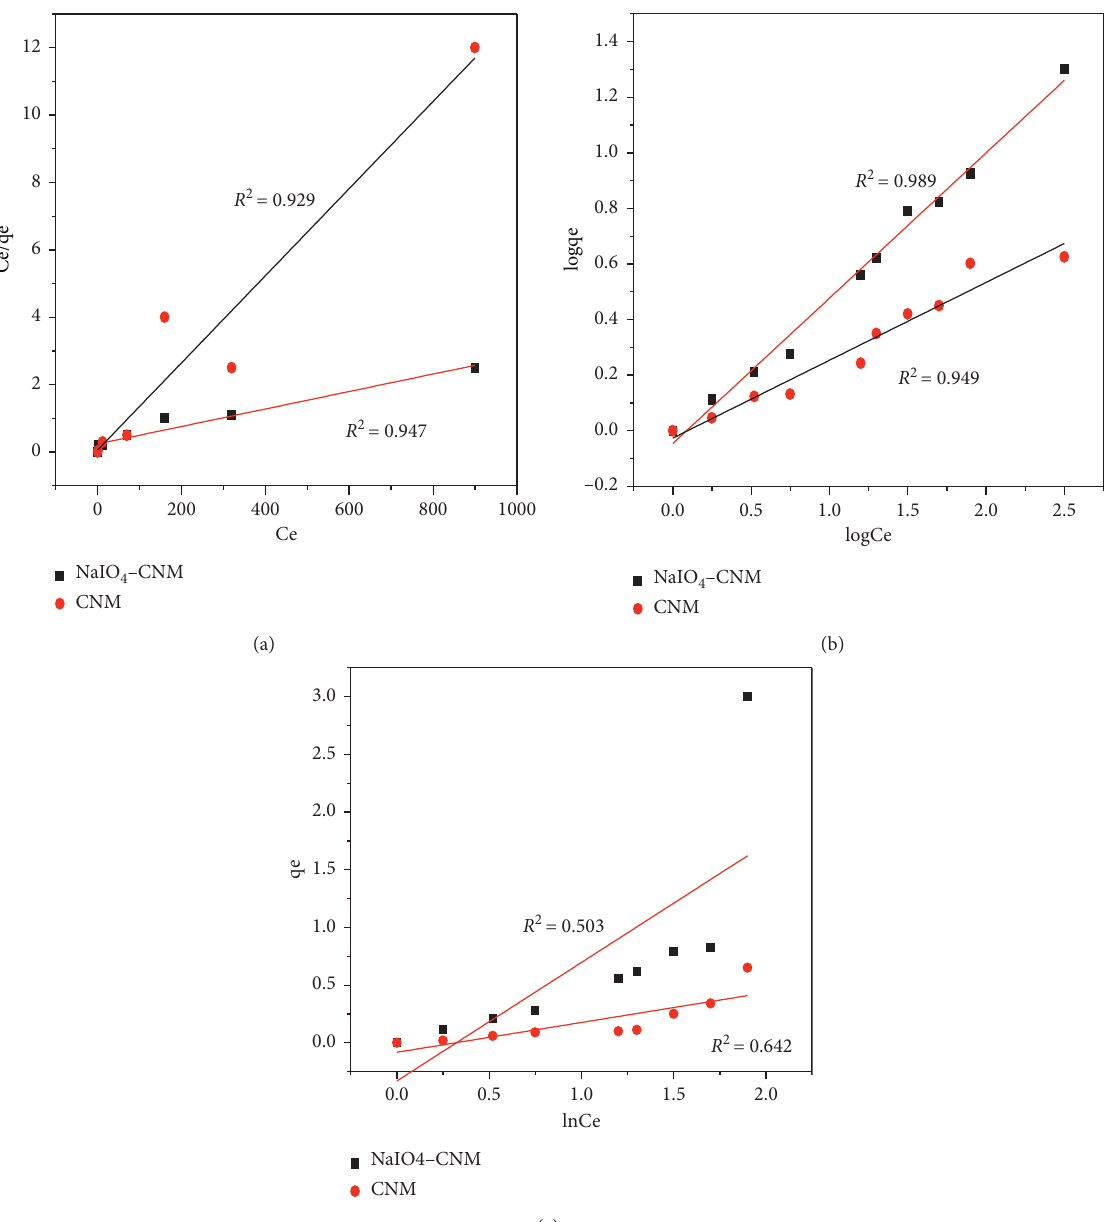
Figure 7: Langmuir (a), Freundlich (b), and Temkin (c) adsorption isotherm for the removal of Pb(II) ions, respectively, at Ci � 30mg/L, pH � 6, adsorbent dose � 1 (g), contact time � 120min, and agitation speed �